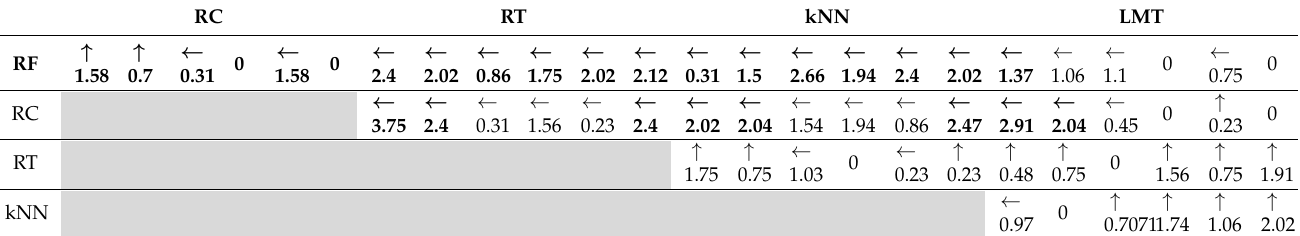
Table A1. Z scores of ML algorithms on cancer prediction. (Illustrations by the authors).